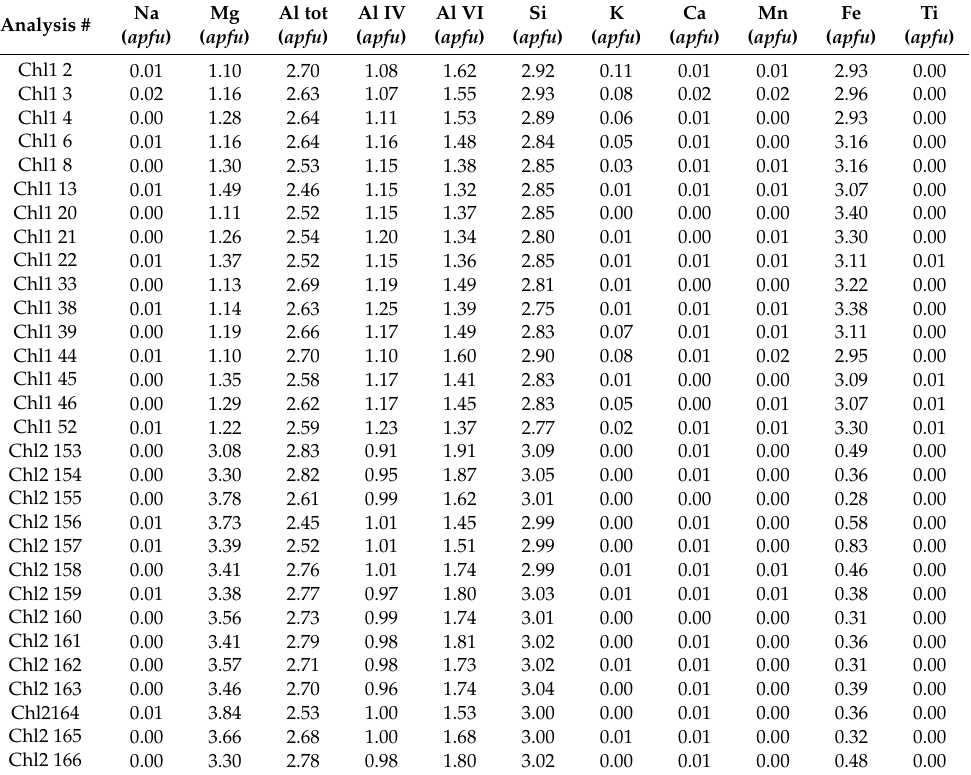
Table 5. Structural formula and occupancy sites for chlorite Chl1 and Chl2 calculated on a basis of 14